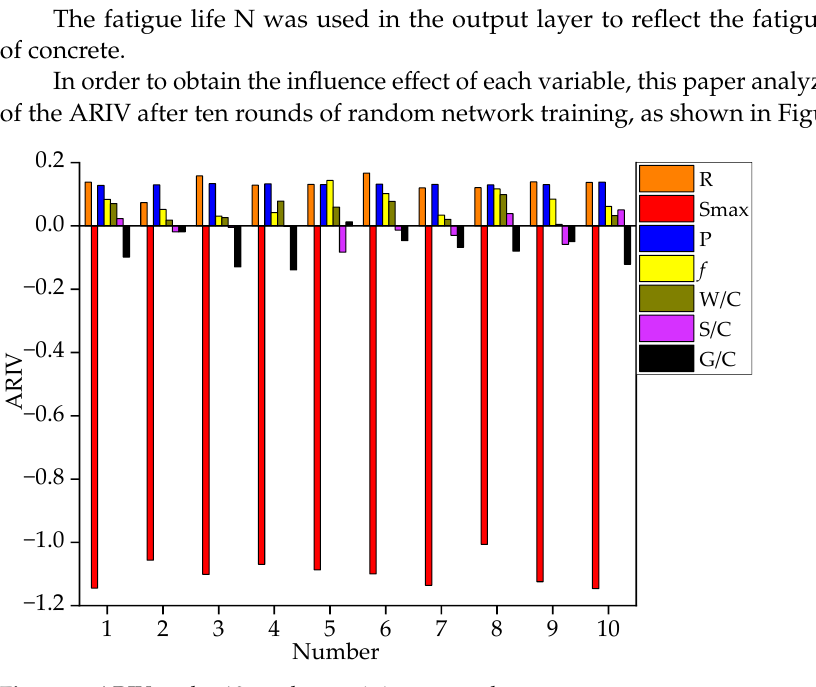
Figure 5. ARIV under 10 random training